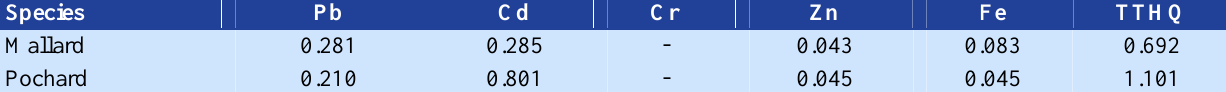
Table 2. Estimated target hazard quotients (THQ) for individual metals and total THQ from consumption of the pectoral muscle of mallard and pochard from the South Eastern region of the Caspian Sea Species Pb